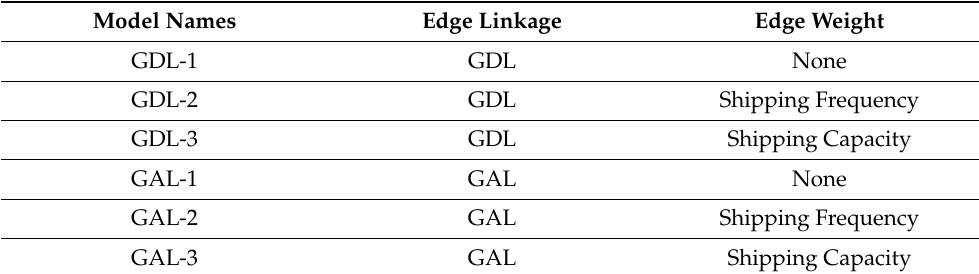
Table 1. Models used in this study with settings on edges. Model Names Edge Linkage Edge Weight GDL-1 GDL None GDL-2 GDL Shipping Frequency GDL-3 GDL Shipping Capacity GAL-1 GAL None GAL-2 GAL Shipping Frequency GAL-3 GAL Shipping